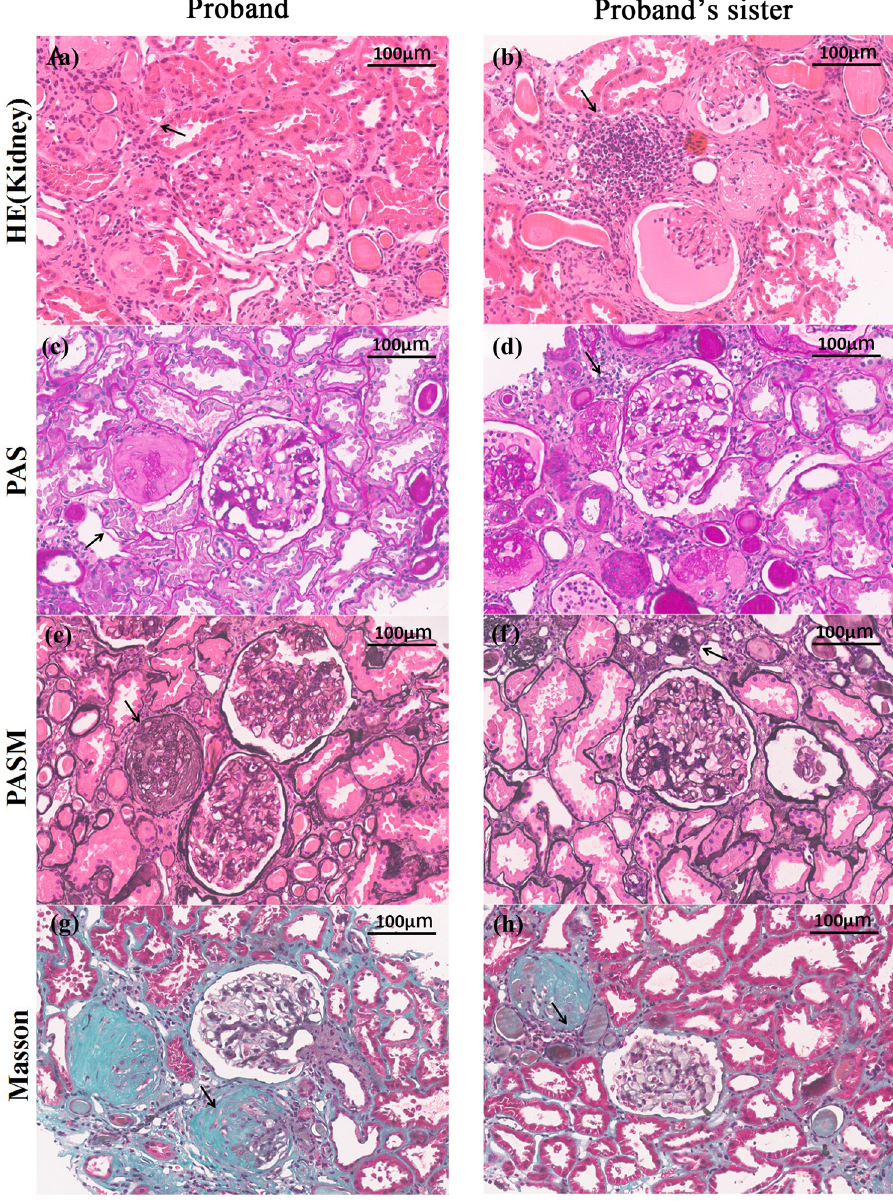
Figure 3: The pathological examination of kidney tissue. ( a – h ) HE, PAS, PASM, and Masson's staining (× 200 ) of pathological sections of kidney tissue from the patient ( a, c, e, g ) and her sister ( b, d, f, h ) respectively. Under the microscope, interstitial lesions were mainly seen including moderate tubular atrophy and interstitial fi brosis. Glomerulopathy was slight and some glomerulosclerosis was seen. The arrow designates